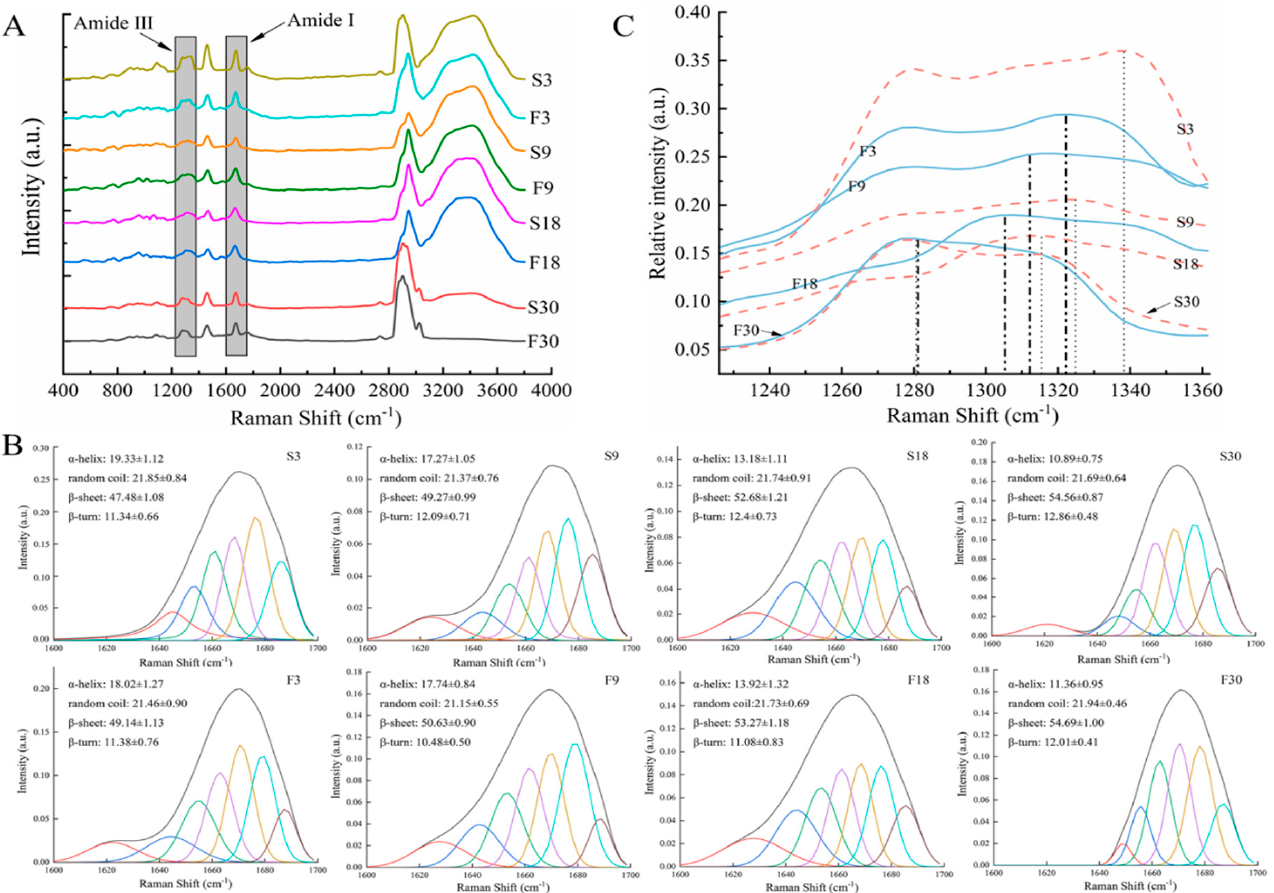
Figure 4. Effect of dehydration treatment on Raman spectra ( A ), iterative curve-fitted ( B ), and amide III region of Raman spectra ( C ) of thawed large yellow croakers.